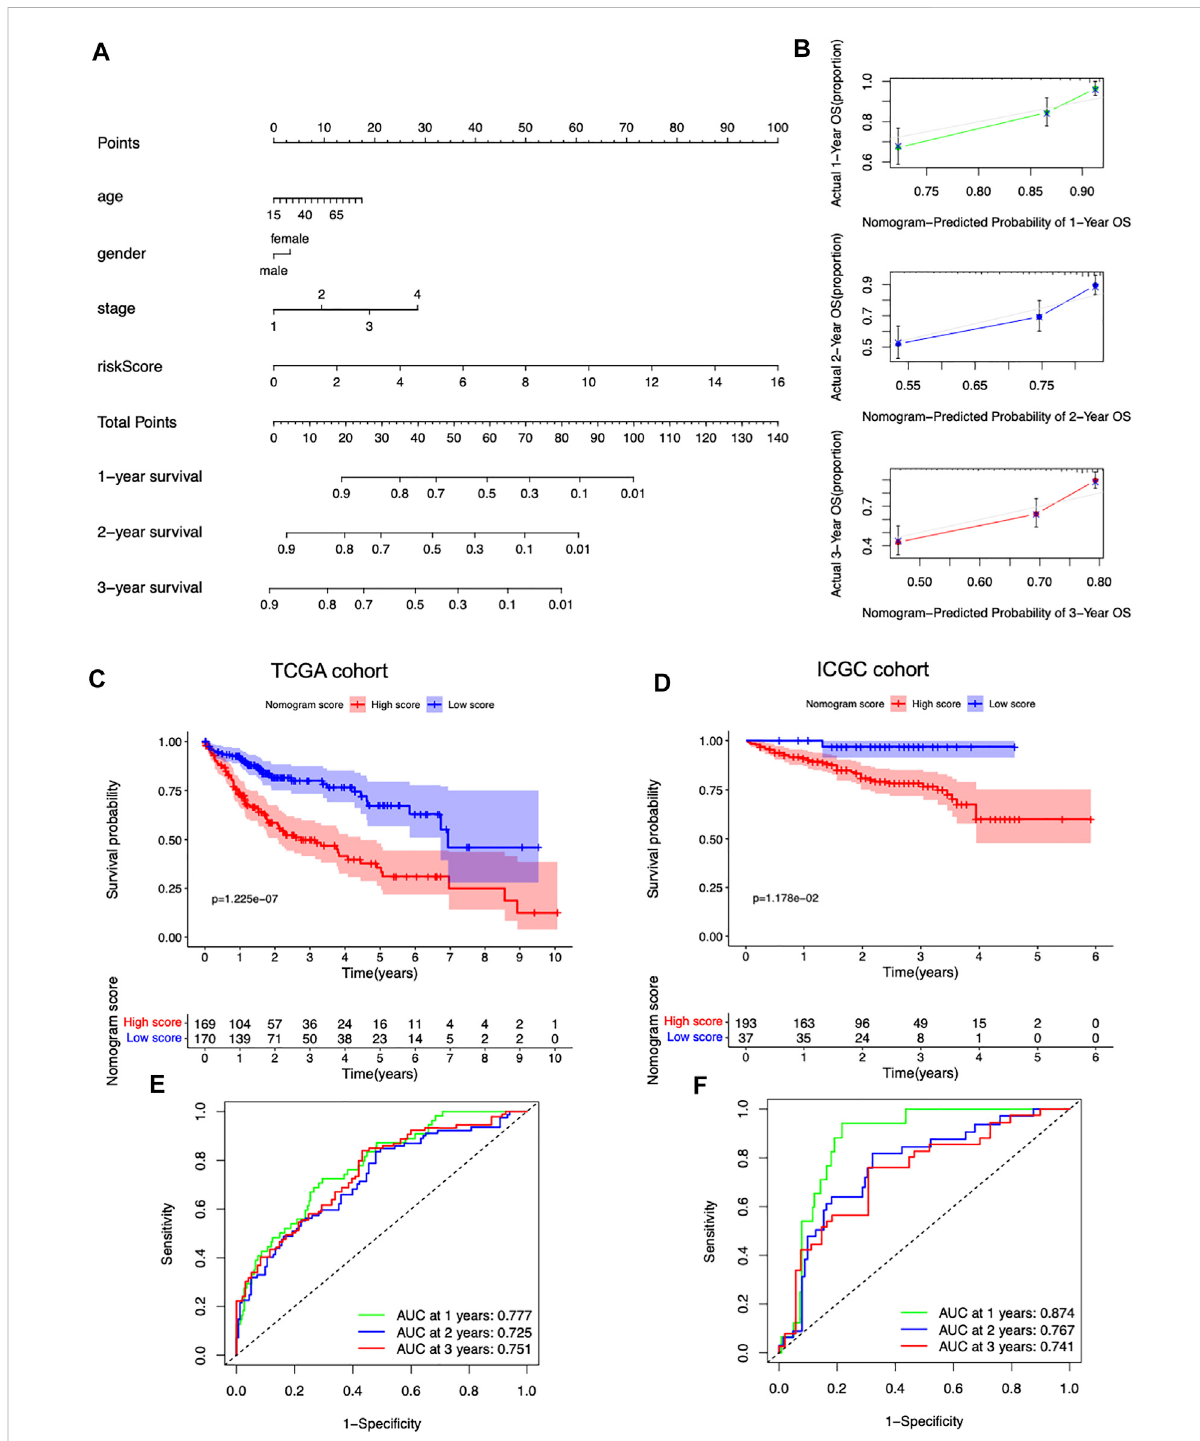
FIGURE 6 Predictive nomogram development and validation. (A) Nomogram based on the risk score and the clinical factors. (B) 1-, 2-, and 3-year calibration plots of the nomogram. (C) Survival curves strati fi ed by the nomogram score in the TCGA cohort. (D) Survival curves strati fi ed by the nomogram score intheICGCcohort. (E) ROC analysis ofthenomograminthe TCGAcohort. (F) ROC analysis of thenomogram intheICGC